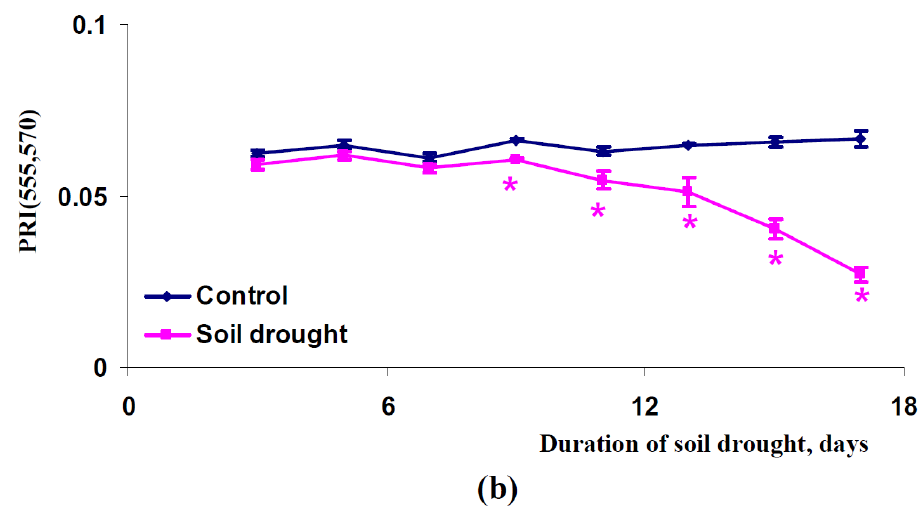
Figure 8. Dependences of the PRI(515,570) ( a ) and PRI(555,570) indices ( b ) in the canopy of wheat plants cultivated under conditions of a vegetation room on the duration of the soil drought ( n = 45). *, difference between experimental and control indices was significant ( p < 0.05).